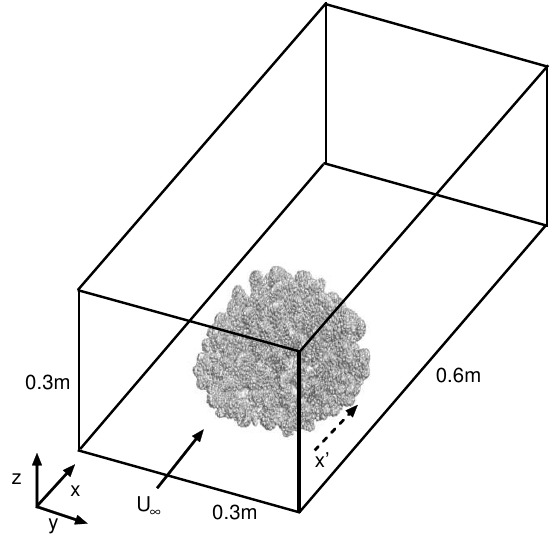
Figure 2. Schematic of flow domain used in the simulation (not to scale). x = 0 indicates the beginning of the flow domain, while x (cid:48) = 0 represents the beginning (front edge) of the coral in the flow domain.